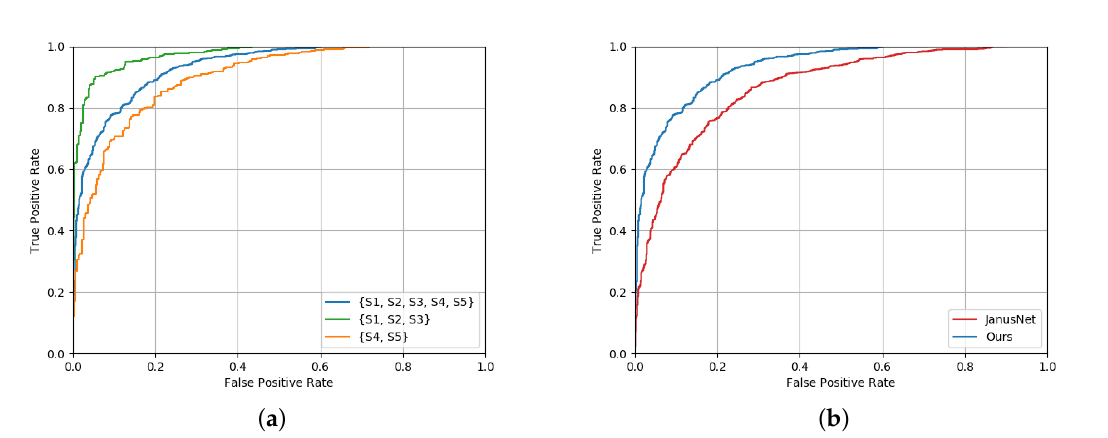
Figure 8. In graph ( a ), the ROC curves obtained by the proposed network computed on different splits of the Pandora dataset are reported (for further details, see Section 4.1). In ( b ), the ROC curves of the proposed method and the JanusNet architecture [21] are